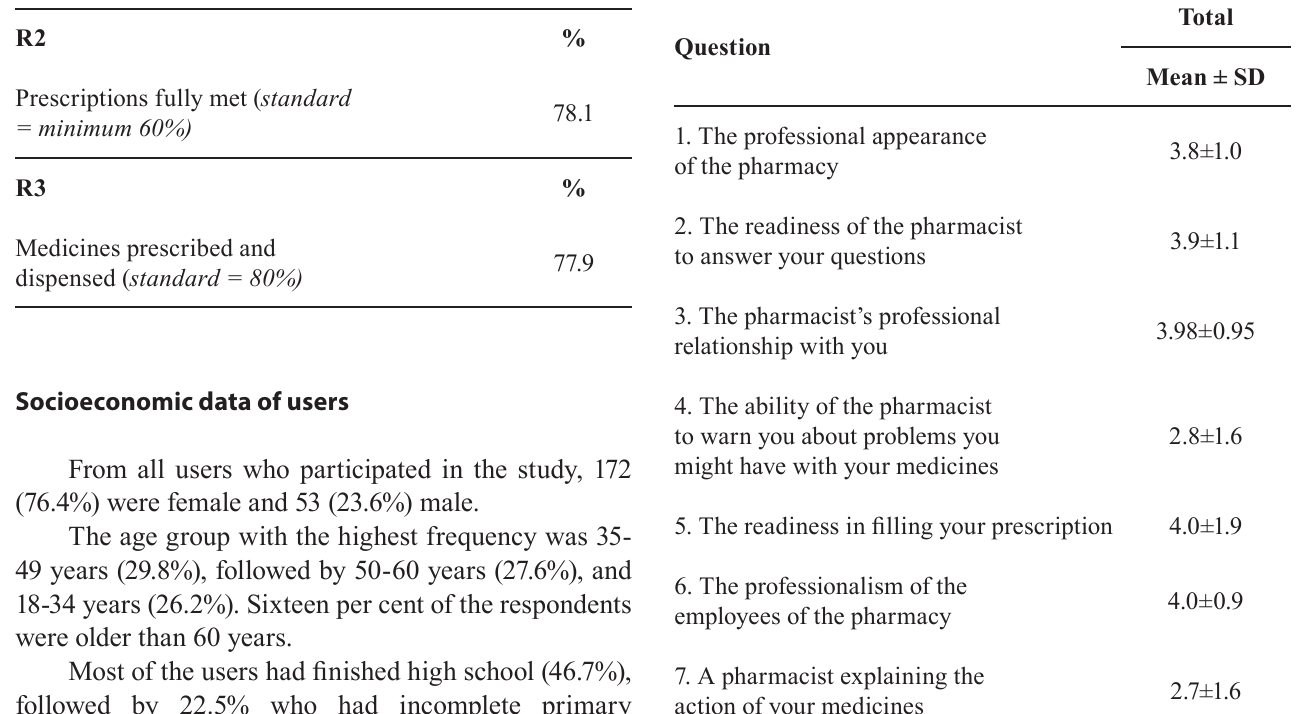
TABLE IV - Overall satisfaction levels for each item of the satisfaction questionnaire for pharmacy services, mean and standard